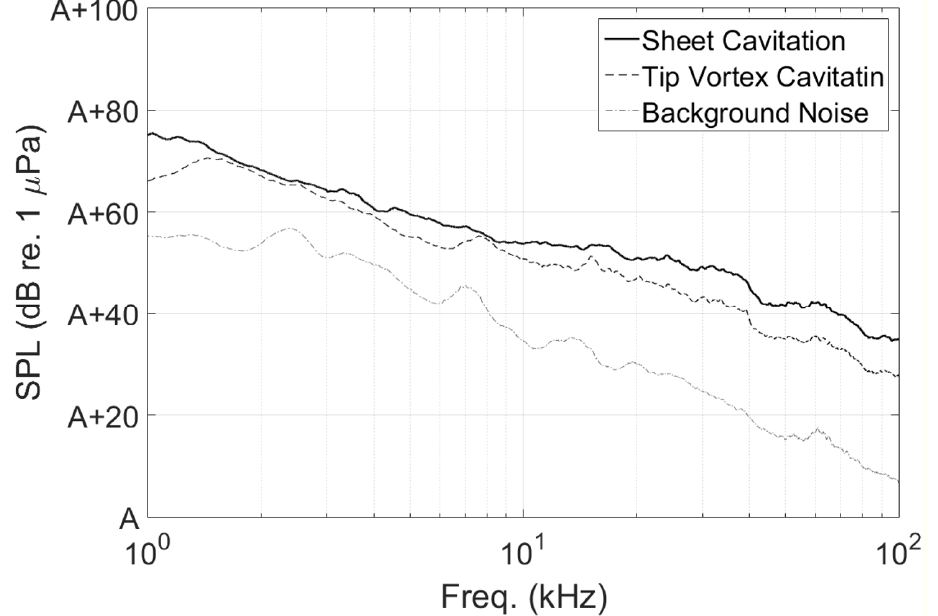
Figure 10. Sound pressure levels of the sheet cavitation, the tip vortex cavitation and the background noise. (A: a reference value).